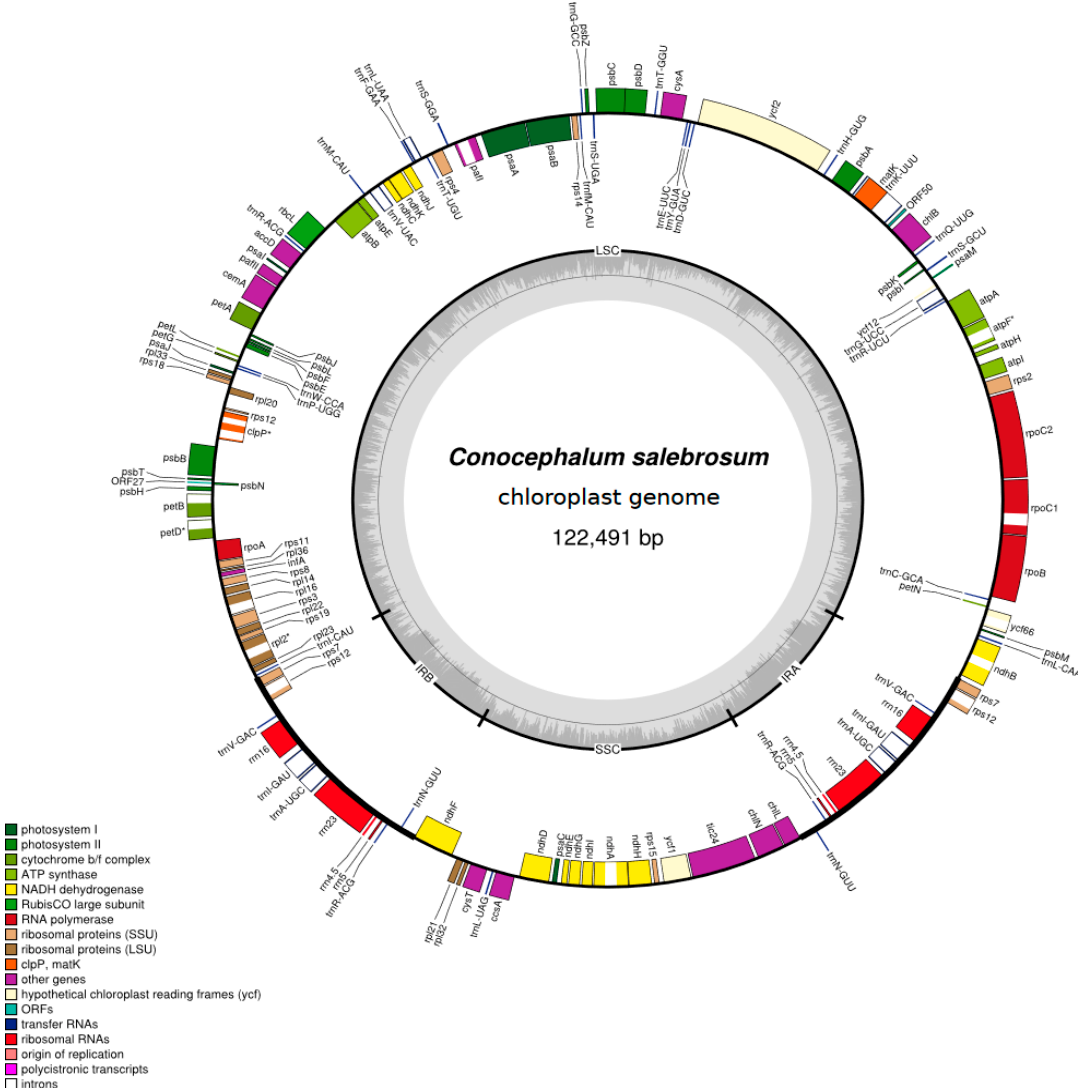
Figure 1. The chloroplast genome of Conocephalum salebrosum . Genes inside and outside the outer circle are transcribed in counterclockwise and clockwise directions, respectively. The genes are color-coded based on their function. The dashed area in the inner circle visualizes the G/C content.